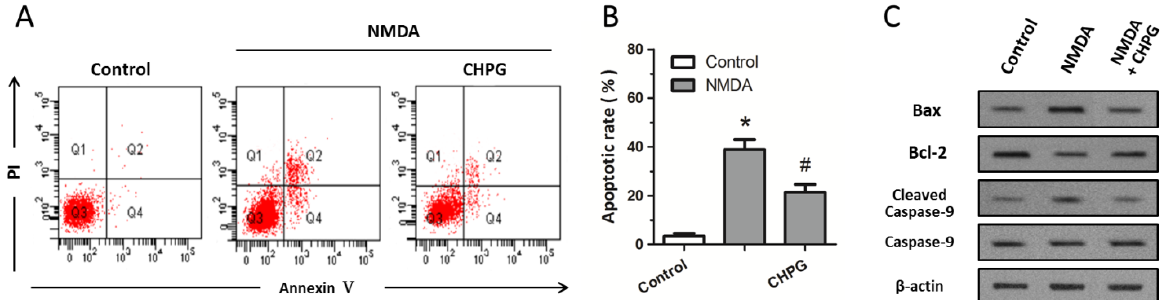
Figure 2. CHPG inhibits NMDA-induced apoptotic cell death. Differentiated PC12